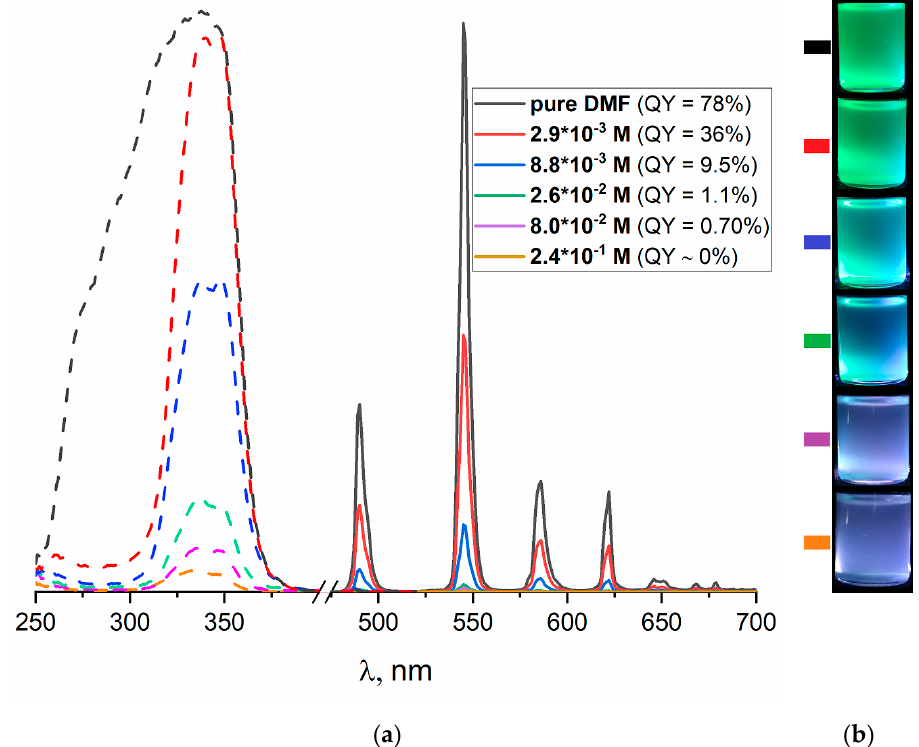
Figure 4. Excitation and emission ( λ ex = 340 nm) spectra for the suspensions of 3 in DMF solutions of cinnamal ( a ). Digital photographs of the suspensions of 3 with the corresponding cinnamal concentration under λ ex = 365 nm ( b ).